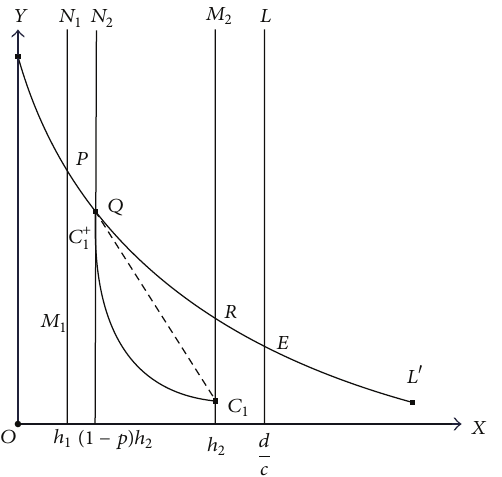
Figure 7: The orbit starting from the point 𝑄 (Case 1 in Section 4.1.2).